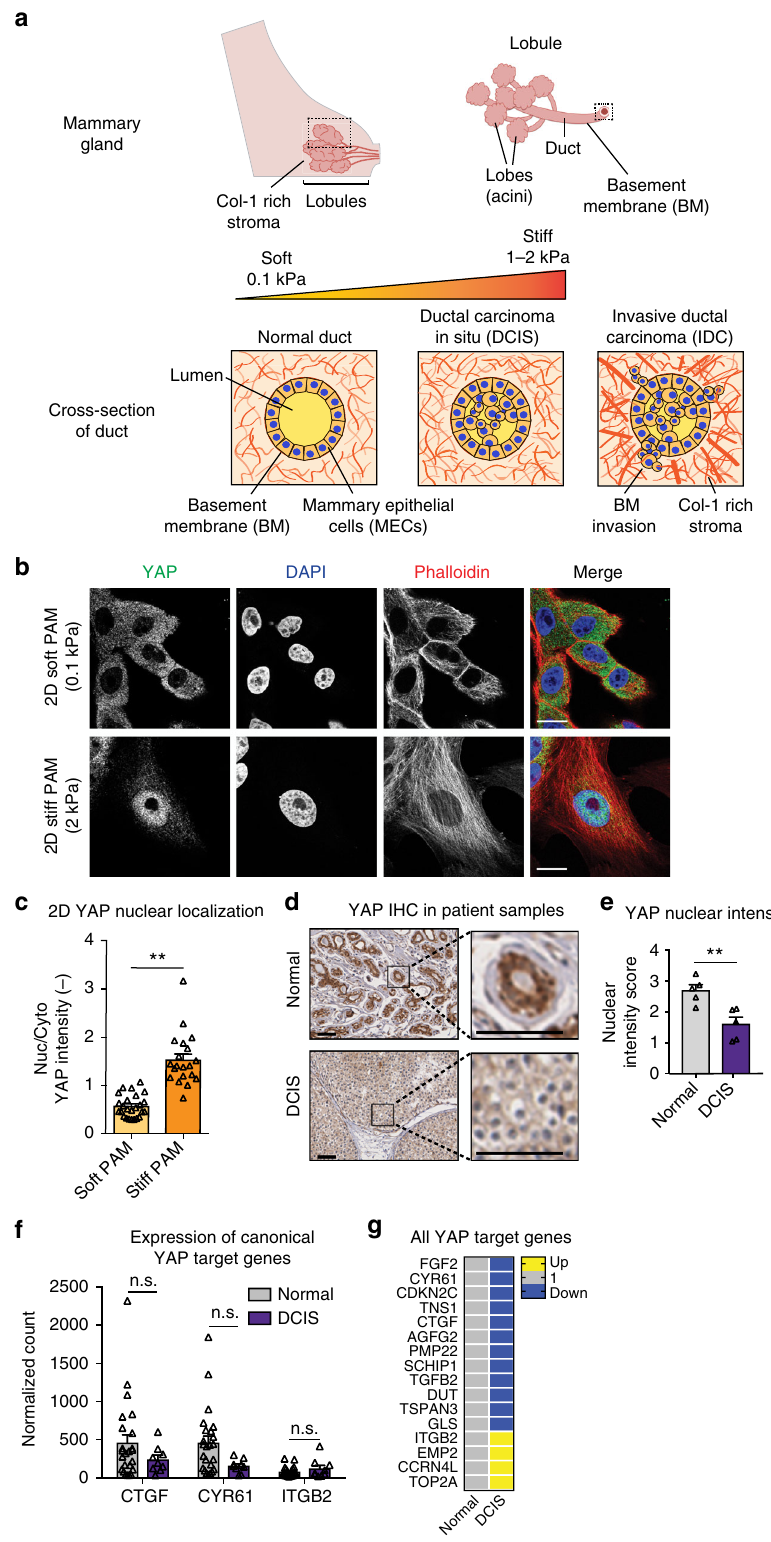
Fig. 1 YAP is not activated during DCIS. a Schematic of ductal carcinoma progression. b MCF10A cells seeded on col-1-coated PAM gels. Bars: 10 µ m. c YAP quanti fi cation from 2D gels. ** p < 0.0001, one-way ANOVA followed by Tukey post hoc comparison tests, symbols represent each cell, n = 9 – 14 cells per hydrogel. d YAP staining in primary tissues. Bars: 50 µ m. e Quanti fi cation of YAP IHC intensity. ** p < 0.01, unpaired t test, symbols represent each patient sample, n = 5 normal and 5 DCIS patients. Expression of f canonical and g all YAP target genes in patient samples. n.s. not signi fi cant, one-way ANOVA followed by Tukey post hoc comparison tests, symbols represent each patient sample, n = 24 normal and 9 DCIS patients. All bar charts display mean ± SEM. All measurements were taken from distinct